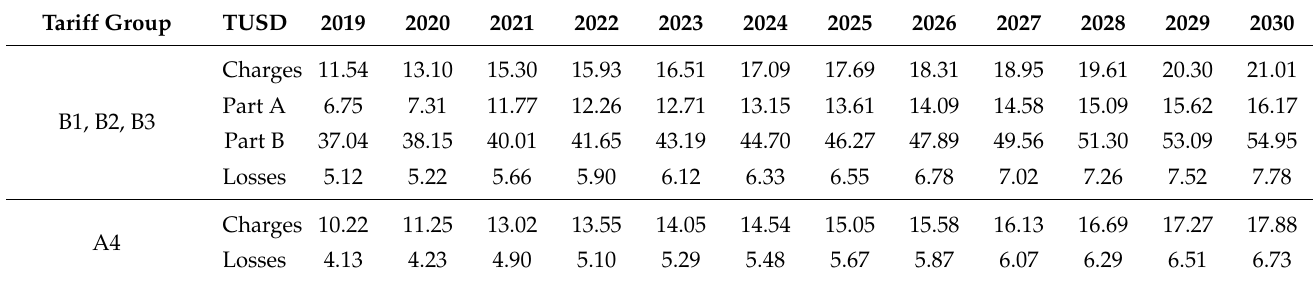
Table A6. Distribution System Use Tariffs (TUSD) by tariff group and components for Enel Rio, in